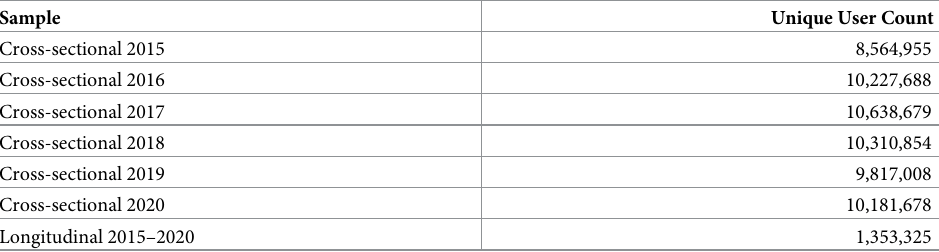
Table 1. Counts of unique US users per sample and year.